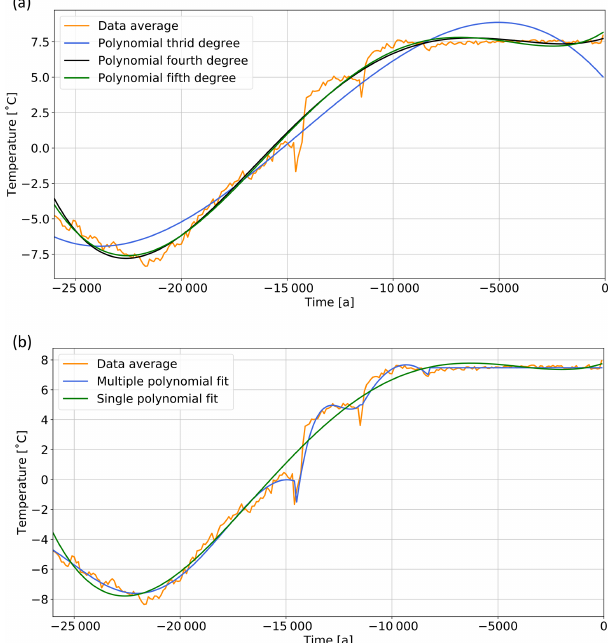
Figure 9. Trend for the paleotemperature upper boundary condition of the CEBS model using (a) single polynomial fits and (b) single and multiple polynomial